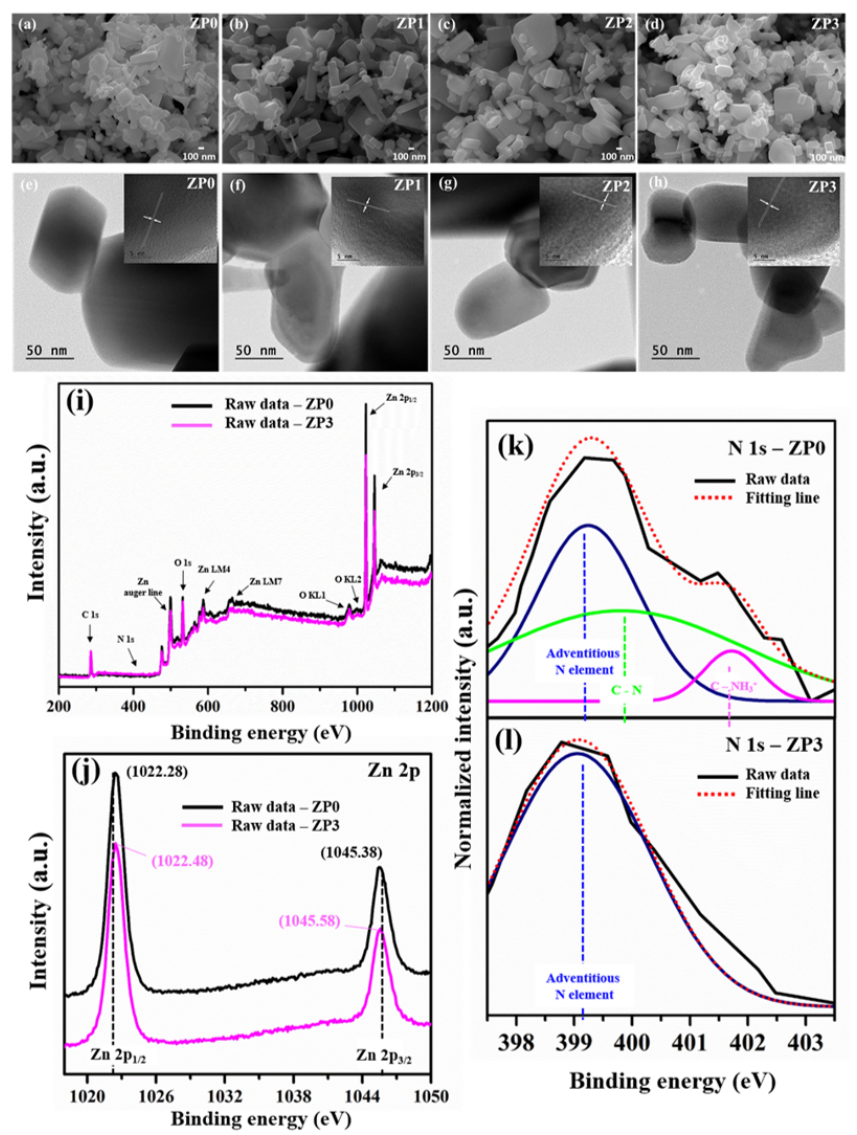
Figure 3. ( a – d ) FE-SEM and ( e – h ) HR-TEM images of ZnO and functionalized ZnO samples and XPS of ZP0 and ZP3 samples; ( i ) XPS Survey spectrum, ( j ) XPS Zn 2p and, ( k ) and ( l ) deconvoluted XPS N 1s of ZP0 and ZP3,